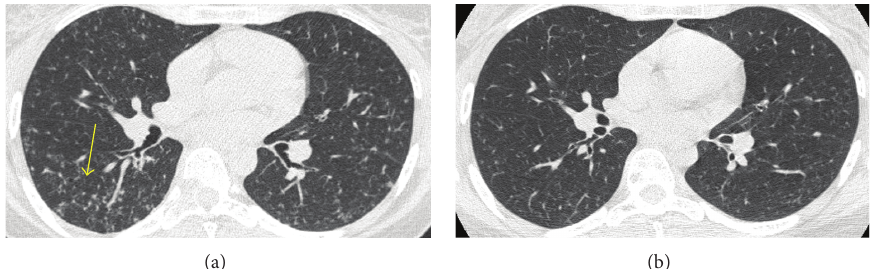
Figure 1: (a) CT of the chest with evidence of bilateral and symmetrical middle lung zone nodules of irregular appearance and cysts. (b) Repeat CT chest 18 months later with disappearance of the nodules and cysts